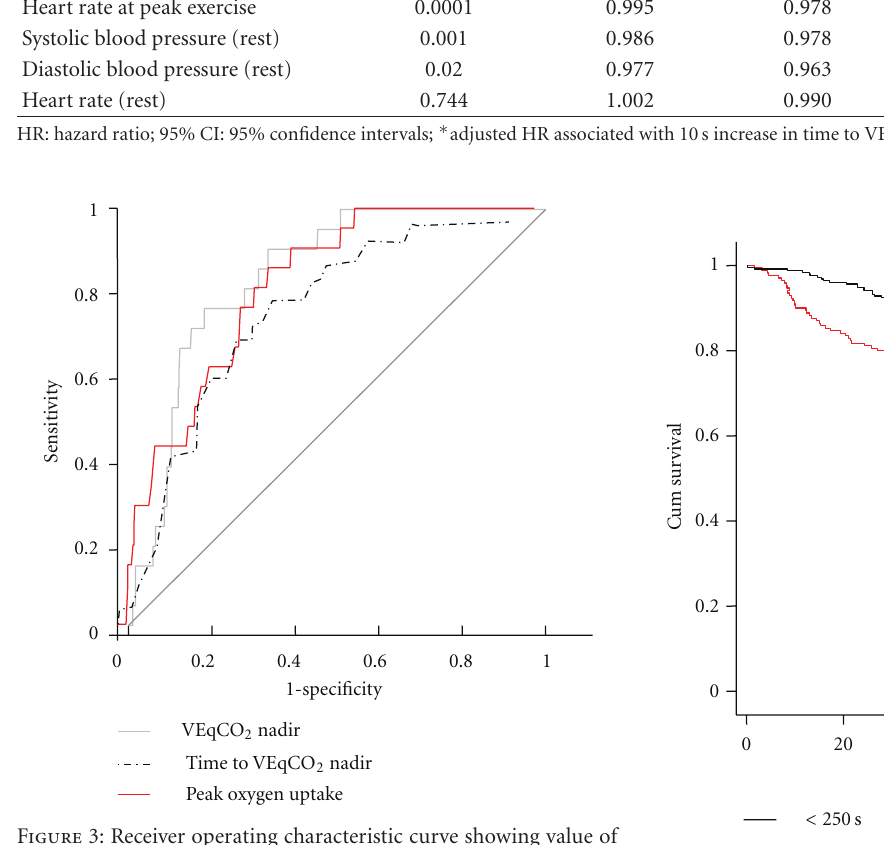
Figure 3: Receiver operating characteristic curve showing value of VEqCO 2 nadir, time to VEqCO 2 nadir, and peak oxygen uptake for predicting all-cause mortality at 12 months. VEqCO 2 nadir: AUC = 0 . 81; P < 0 . 0001; 95% CI = 0.74–0.89; sensitivity = 86; specificity = 62; optimal cut-point = 33; time to VEqCO 2 nadir: AUC = 0 . 75; P < 0 . 0001; 95% CI = 0.67–0.84; sensitivity = 81; specificity = 62; optimal cut-point = 250 s; peak VO 2 : AUC = 0.76; P < 0 . 0001; 95% CI = 0.67–0.85; sensitivity = 86; specificity = 57; optimal cut-point = 20mL · kg − 1 · min − 1 .